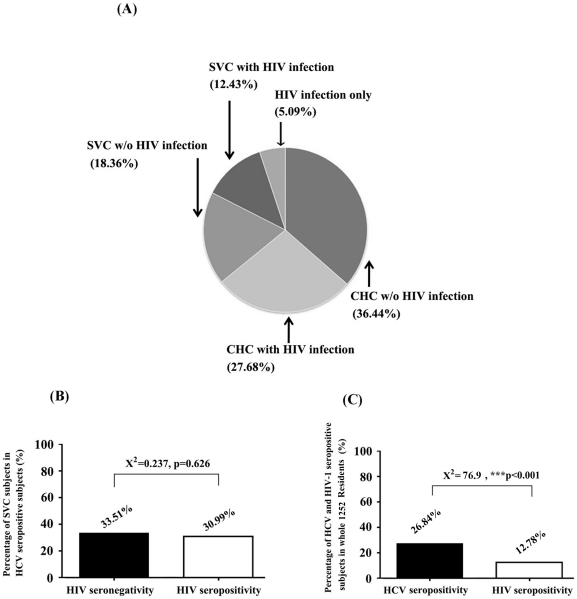
The distributional characteristics of HCV- and/or HIV-infected patients involved in this study.(A) 354 HCV seropositive or HIV-1 seropositive participants were divided into 5 different groups (HIV-noninfected CHC, HIV-infected CHC, HIV-noninfected SVC, HIV-infected SVC, HIV infection only) depending on existence of serum HIV-1/HCV antibodies and plasma HCV RNA. The proportions of each group in 354 subjects were indicated. (B) Comparison of the percentages of SVC subjects in HCV seropositive subjects between HIV-1 noninfected (black square) and HIV-1 infected (empty square) patients. (C) Percentage of HCV (black square) and HIV-1 (empty square) seropositive patients in whole 1252 residents. Pearson Chi-Square tests were performed for comparing the percentage between two different groups shown in (B) and (C). Triple asterisks (***) indicate P values below 0.001.